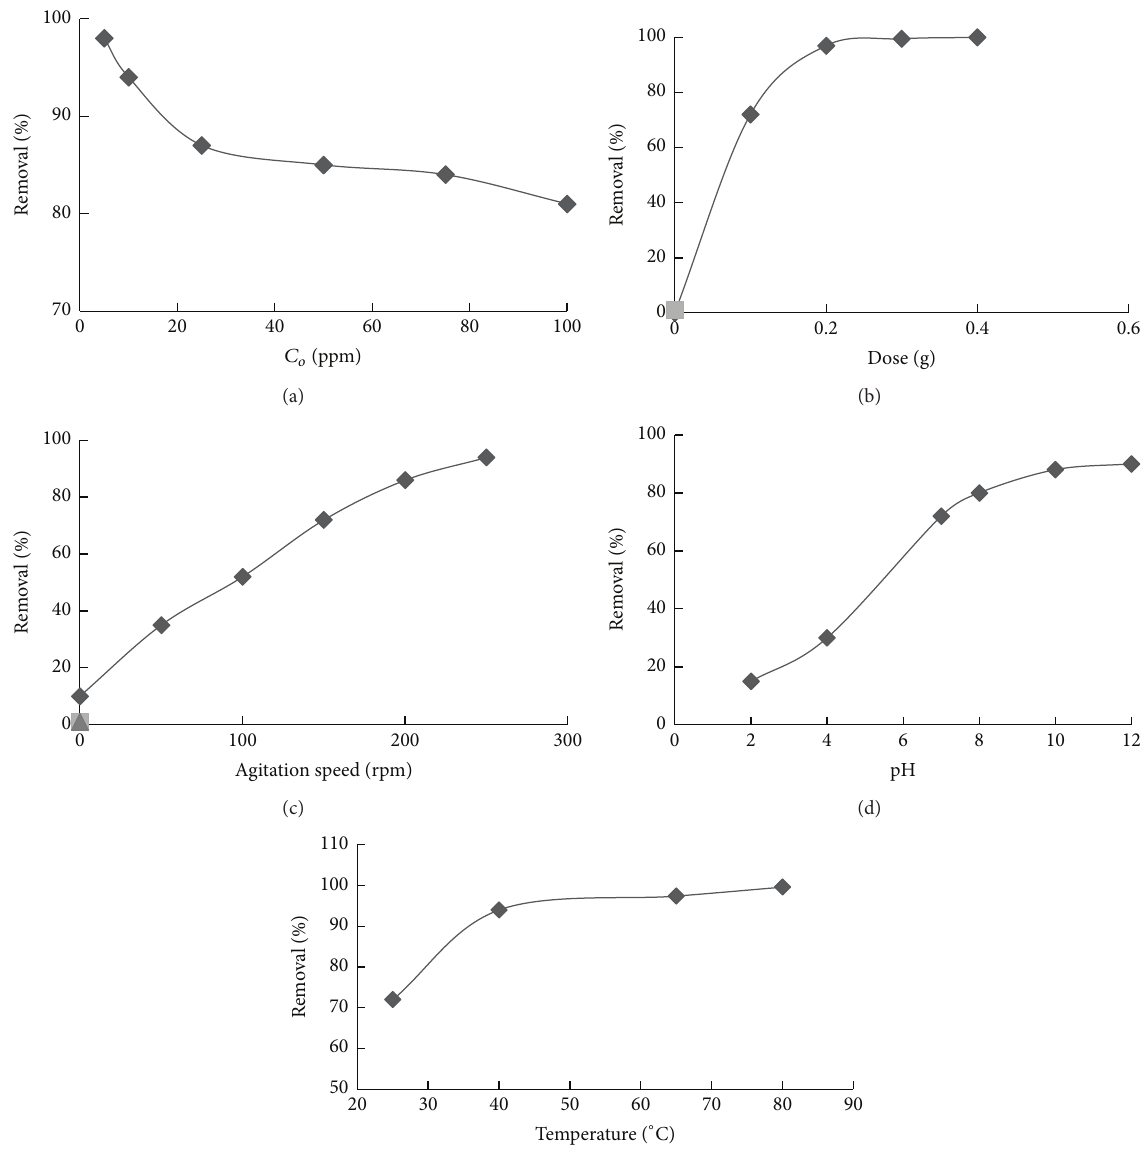
Figure 6: Effect of processing parameters variation on basic violet 16 decolourization process onto composite sheet matrix at equilibrium: (a) effect of initial dye concentration; (b) effect of cation exchanger dosage; (c) effect of agitation speed; (d) effect of dye solution acidity; (e) effect of solution